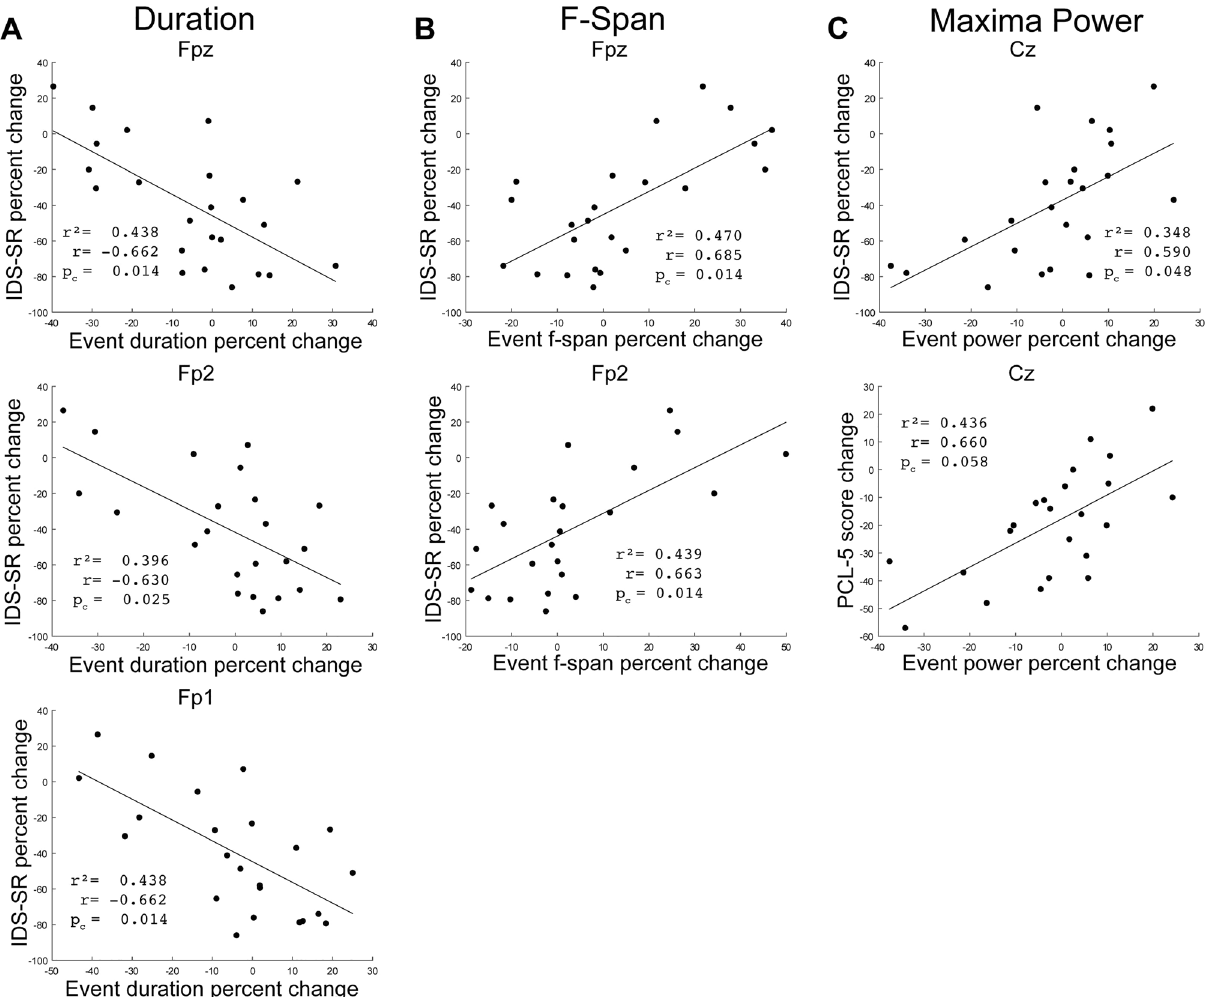
Figure 5. Correlation between change in clinical score and beta event features pre- to post-treatment for each patient (•). ( A ) Percent change in beta event duration vs. IDS-SR percent change for the Fpz, Fp2, and Fp1 electrodes. ( B ) Percent change in beta event frequency span vs. IDS-SR percent change for the Fpz and Fp2 electrodes. ( C ) Percent change in beta maxima power vs. IDS-SR percent change and PCL-5 score change for the Cz electrode. Pearson’s correlation coefficient r, r 2 , and BH-adjusted p-values